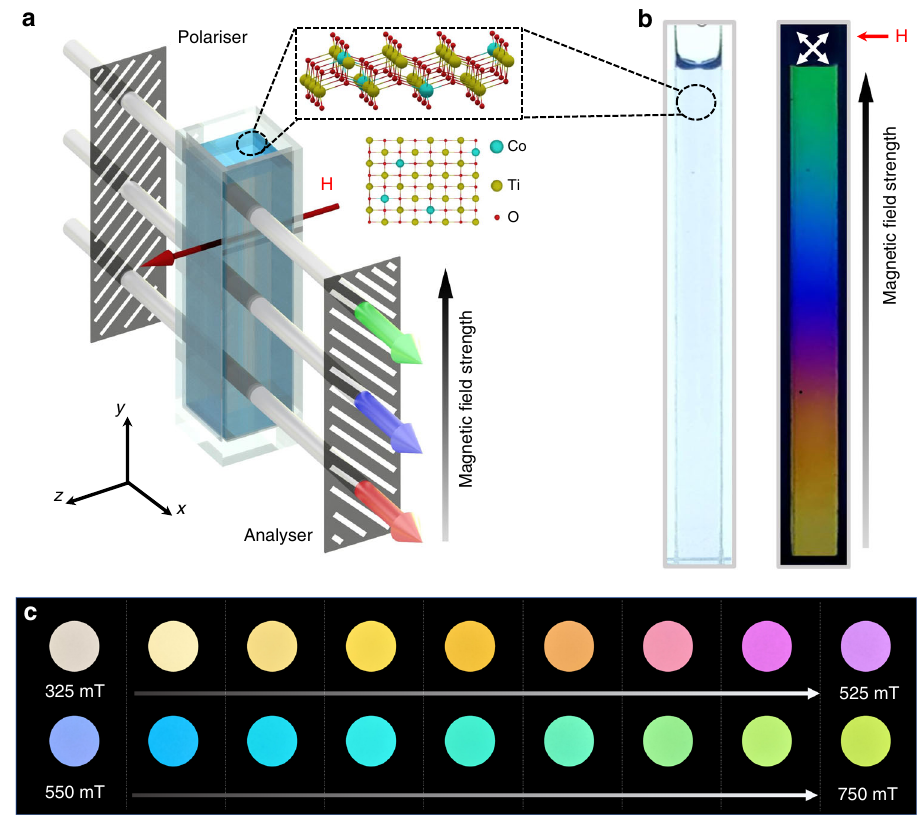
Fig. 1 Magneto-chromatic effect in a 2D CTO aqueous suspension. a Schematic setup of our magneto-optical experiments. A 5.5 cm tall cuvette with 1.0 × 0.5 cm rectangular cross section fi lled with a suspension of 2D CTO crystals is placed between two crossed polarisers, with the magnetic fi eld applied along the z -direction, at 45° to the polariser/analyser. The top-right inset shows schematic atomic structure of 2D CTO. The light path is along the x -direction and the magnetic fi eld is increasing vertically from bottom to top. b Real images of the cuvette fi lled with 0.02 vol% suspensions and illuminated with uniform white light. Left: no colours appear if the polariser/analyser are absent; right: a rainbow of colours is clearly seen in the presence of crossed polarisers. c Real images of the colours of the suspension in uniform magnetic fi eld, as the fi eld is tuned from μ 0 H = 325 mT to 750 mT with a 25 mT